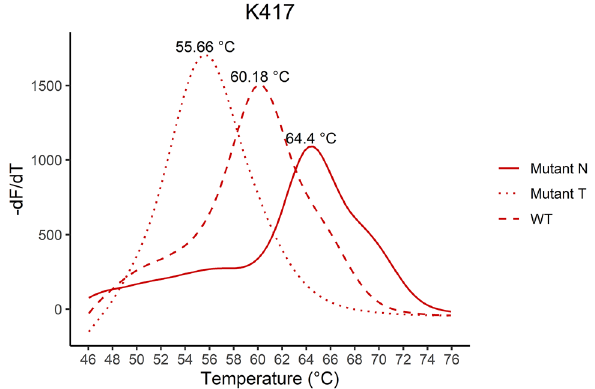
Figure 2. The melting curve analysis of the K417N mutation combined with a WT (K417), K417N and K417T complementary strand. The assay is specific for the K417N mutation resulting in the highest affinity for the sequence encoding Asparagine (N) in codon 417 and a Tm of 64.4 °C. The assay has the additional function as it can detect the K417T mutation at Tm 55.66 °C as well.